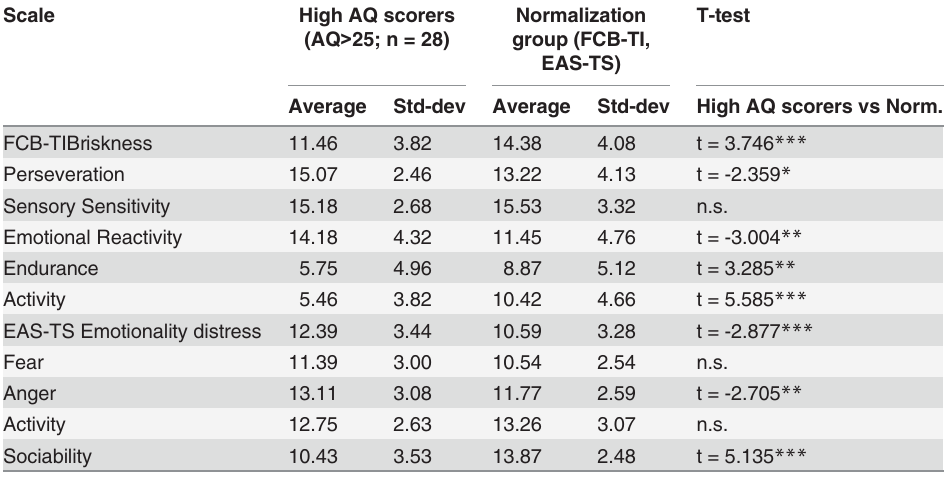
Table 5. Descriptive statistics of FCB-TI and EAS-TS scales in high AQ scorers group and normaliza- tion in respective groups, as well as the results of their comparison with the t-test.